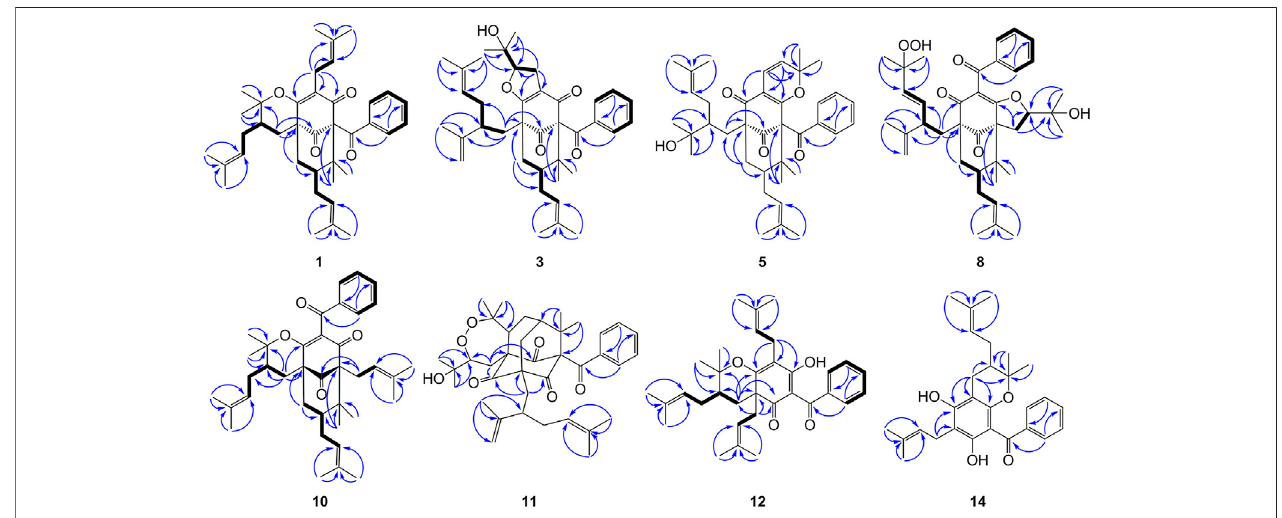
FIGURE 3 | ROESY correlations for compounds 1 , 4 , 5 , 8 , 11 , and 12 .